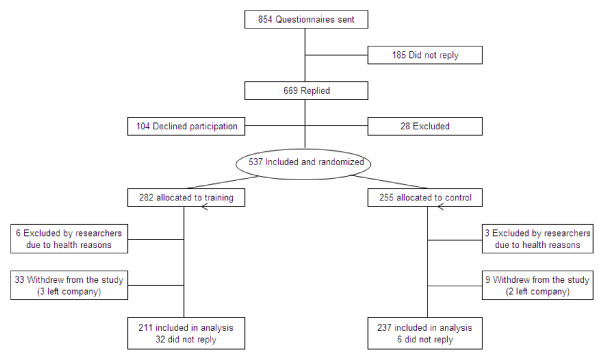
Flow of participants throughout the intervention.